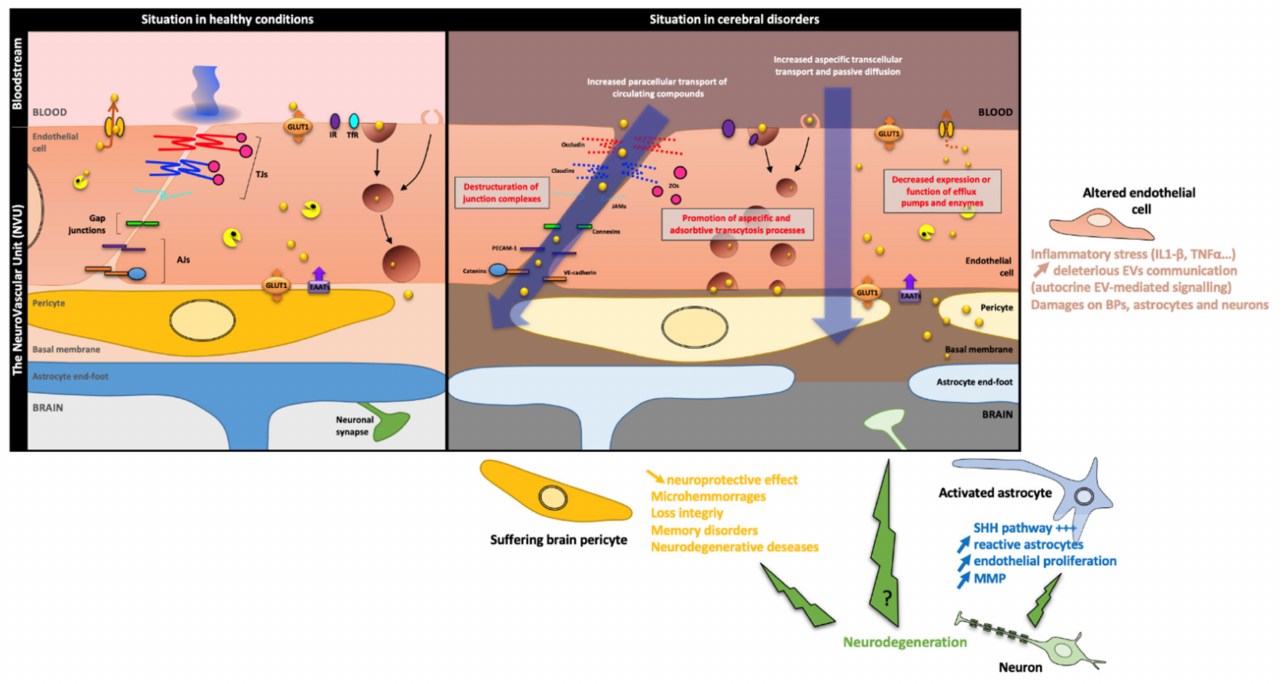
Figure 4. Disturbances of cell–cell communication routes to maintain the BBB in pathological dis- orders. Environmental changes due to age, external stimuli or certain neurodegenerative pathologies can alter the BBB over time. A loss of TJ sealing, a disruption of efflux pump activity and an increase in vesicular transport in ECs are therefore observed. Direct damage to ECs implies a deleterious inflammatory stress for the BBB, which will send some stress signals to other components of the NVU via EVs. To some extent, the BBB becomes more permeable to circulating molecules allowing the entry of external compounds and the extravasation of leukocytes into the CNS. The cell–cell com- munications between ECs and the different components of the NVU are altered. The damage on BP coverage leads to a decrease in the neuroprotective effect of these cells, leading to microhaemorrhages and neurodegenerative diseases. Activated astrocytes will promote endothelial proliferation with overactivation of the SHH signalling pathway, as well as a degradation of the endothelial basement membrane due to MMPs secretion. The direct role of neuron upon a neurodegenerative-dependent stress on the BBB features remains obscure. However, some studies suggest an indirect role based on altered cell–cell communication processes with both astrocytes and BPs leading to a BBB